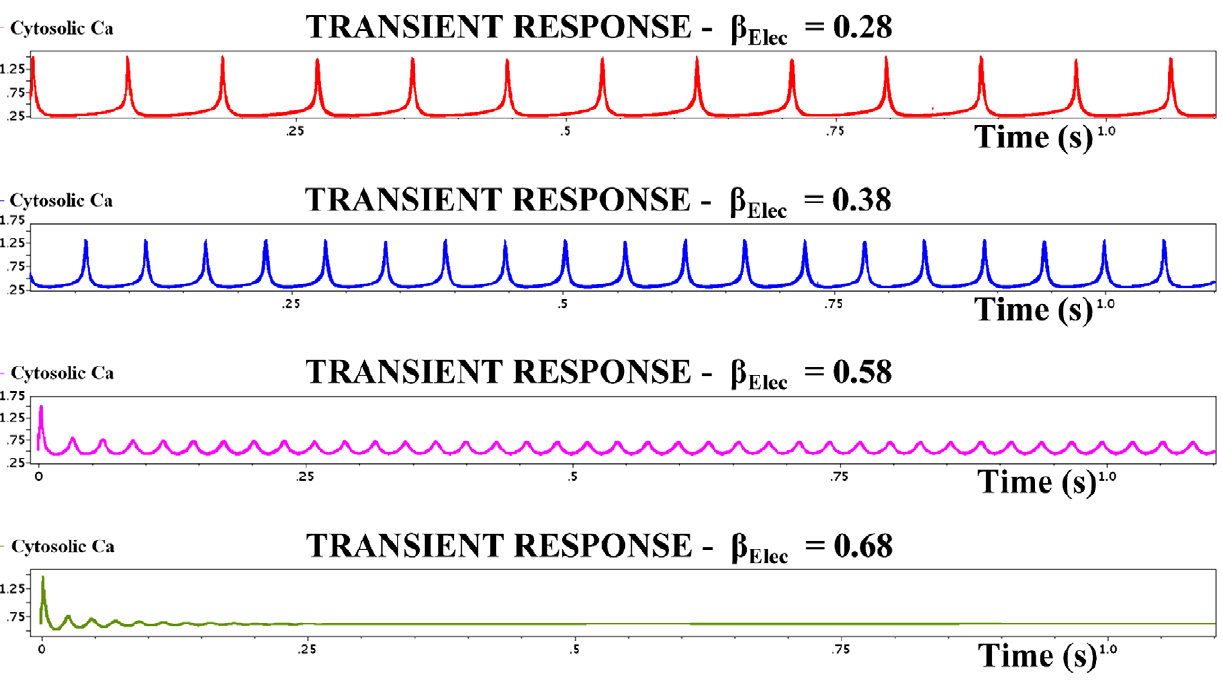
Figure 12. Transient analysis of the m ~ n ~ 2, p ~ 4 intracellular Ca 2 + circuit simulated for the values shown in Table 6 and for four different b Elec values. The electrical parameters are listed in Table 9. The figure illustrates the transition of the electric system from asymptotically stable limit cycles to asymptotically stable fixed points. Damped oscillations are again generated after the system’s bifurcation point, which corresponds to b Elec & 0 : 7 . The simulated results exhibit satisfying resemblance with the simulation graphs presented in [1].